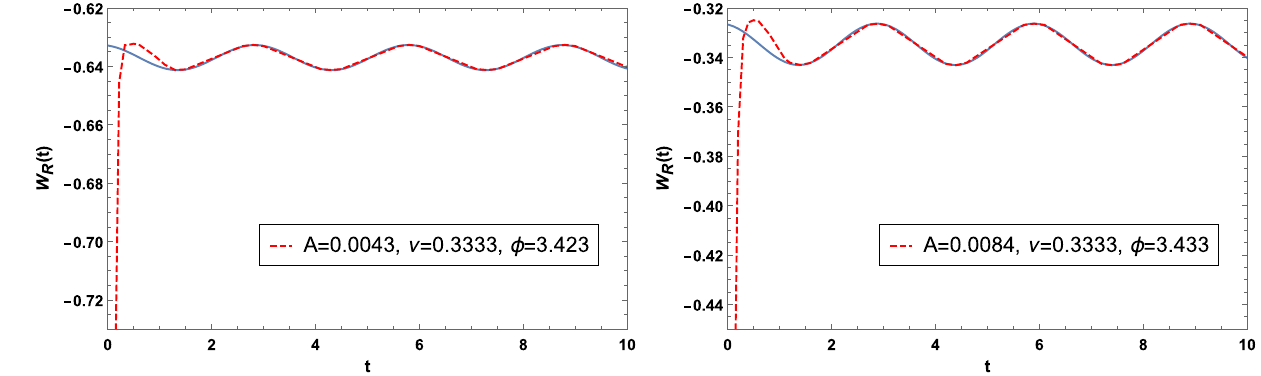
Fig. 1 W R ( t ) in terms of the boundary time t for l = 1, k = 0 . 3 and μ / T = 3 . 15. For the left (right) graph μ f f T f = 0 . 1012 ( 0 . 1246 ) . The static potentials for left (right) graph is